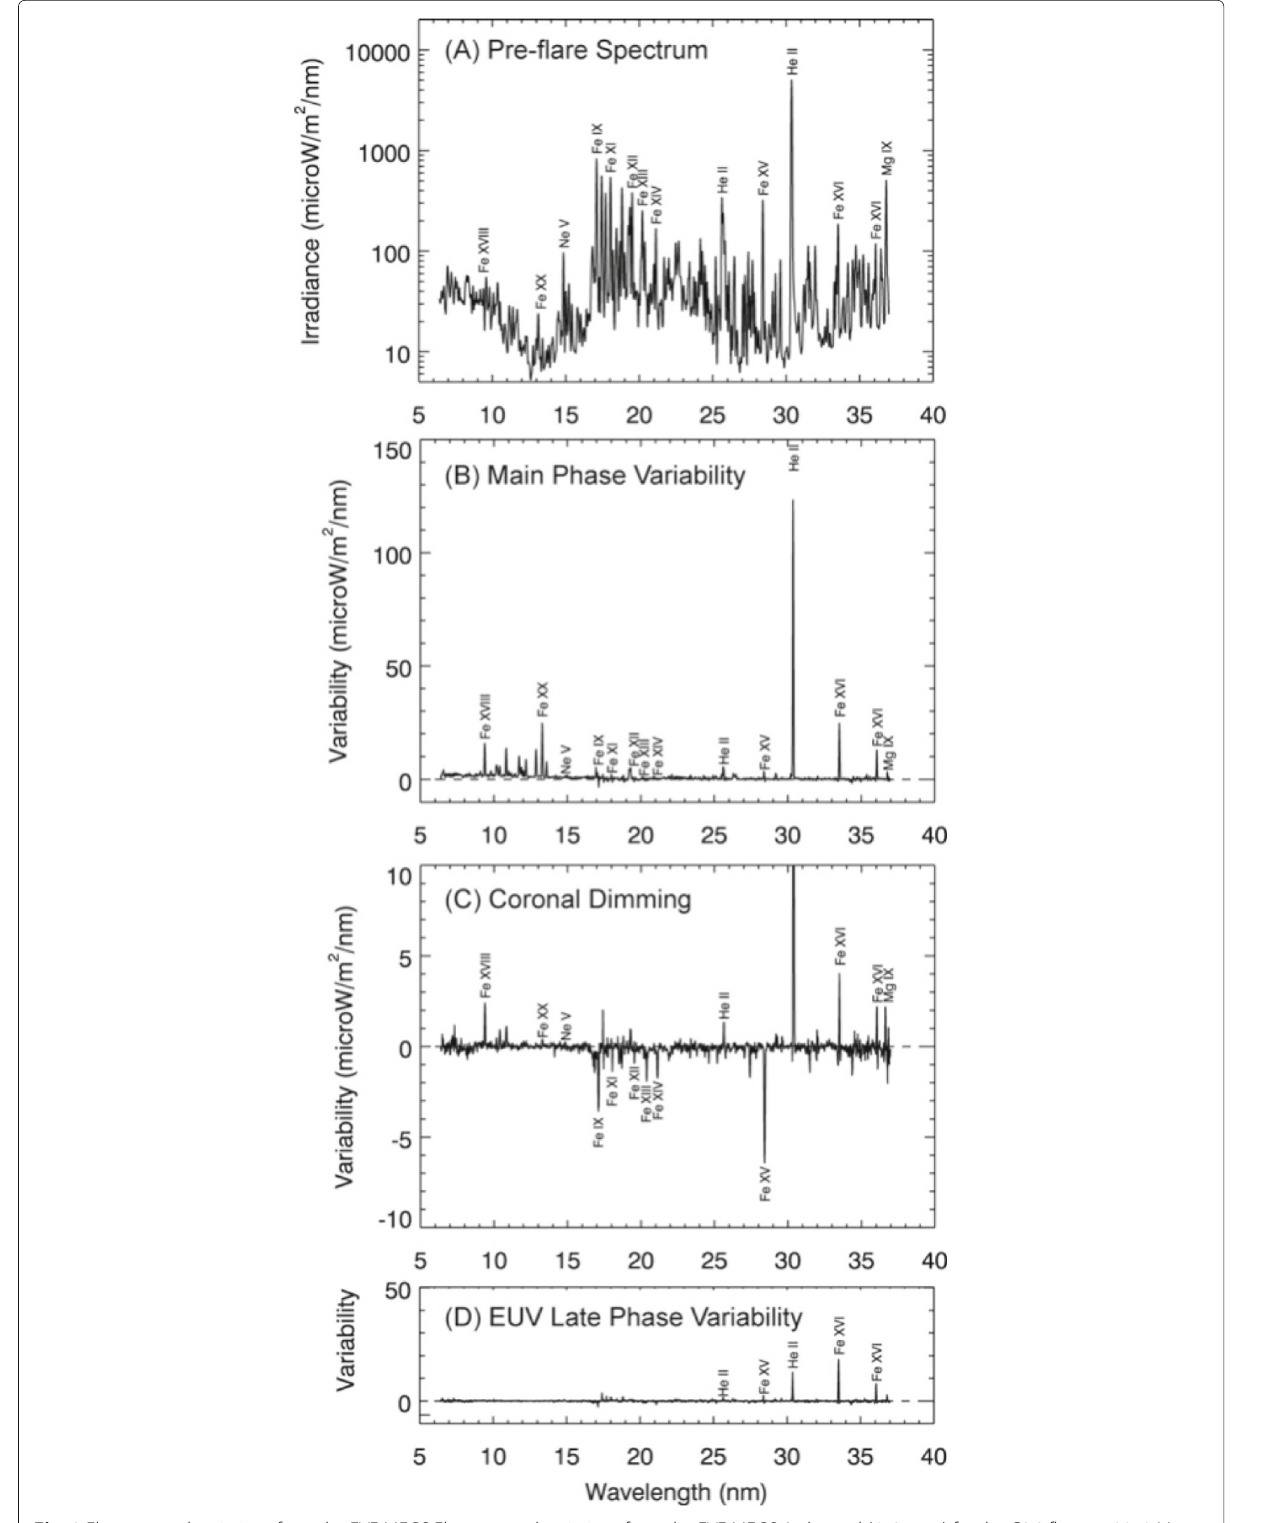
Fig. 9 Flare spectral variations from the EVE MEGS Flare spectral variations from the EVE MEGS A channel (6–37 nm) for the C8.8 flare on 2010 May 5 as adapted from Woods et al. (2011). A The pre-flare spectrum. B – D The variability between the pre-flare irradiance and the main phase, coronal dimming, and EUV late phase, respectively. These results used 5-min averages taken at the times indicated in Fig. 8 as vertical dashed